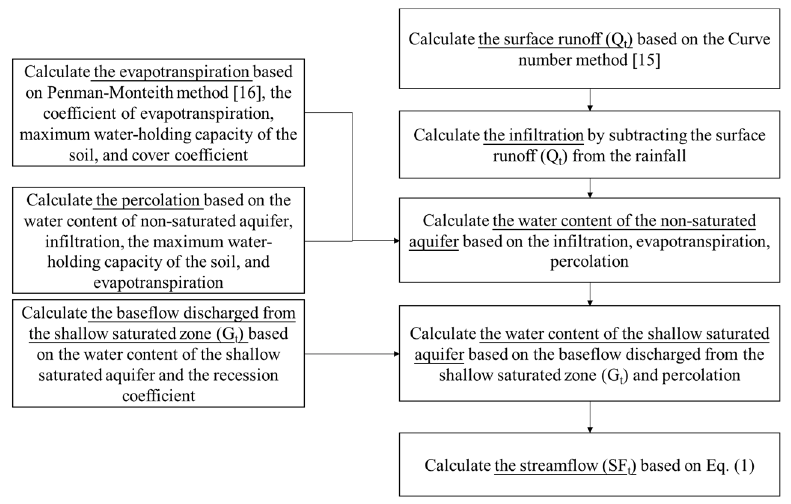
Figure 1. Flowchart of the derivation process of the streamflow from weather data [16].